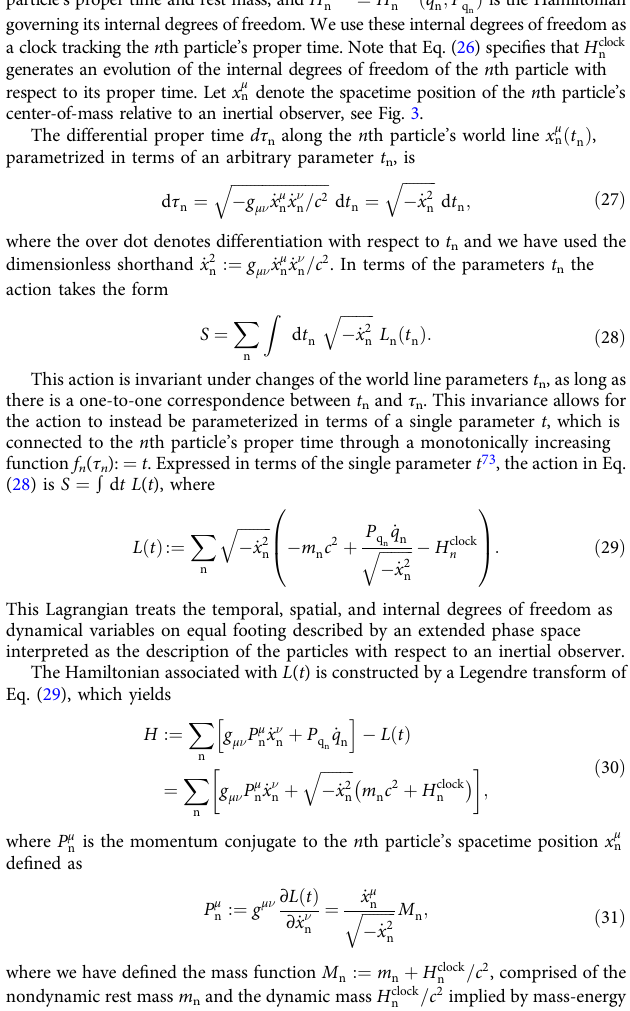
Fig. 3 Degrees of freedom of n th particle. The temporal degrees of ; P 0 Þ and center-of-mass degrees of freedom ð x i freedom ð x 0 n n relativistic particle are depicted. This particle carries an internal degree of Þ that is used to construct a clock which measures the n th freedom ð q n ; P q n particle ’ s proper